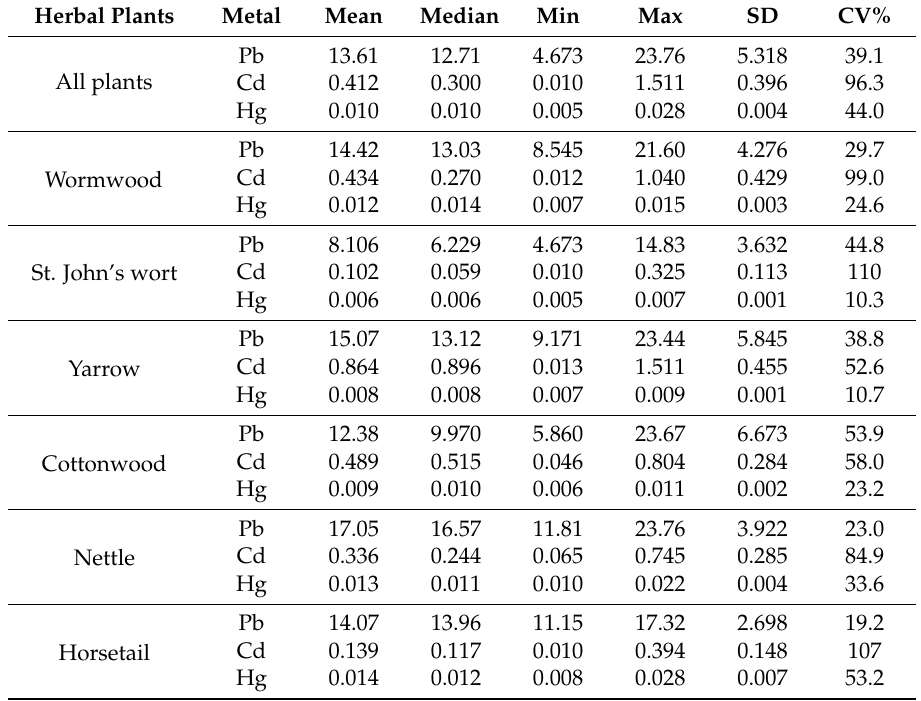
Table 1. Concentration of Pb, Cd and Hg in plants (wormwood, St. John’s wort, yarrow, cottonwood, nettle, horsetail)